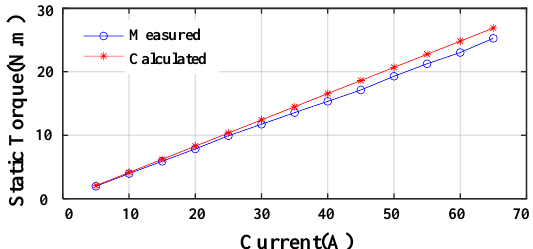
Figure 12. Measured and Calculated static